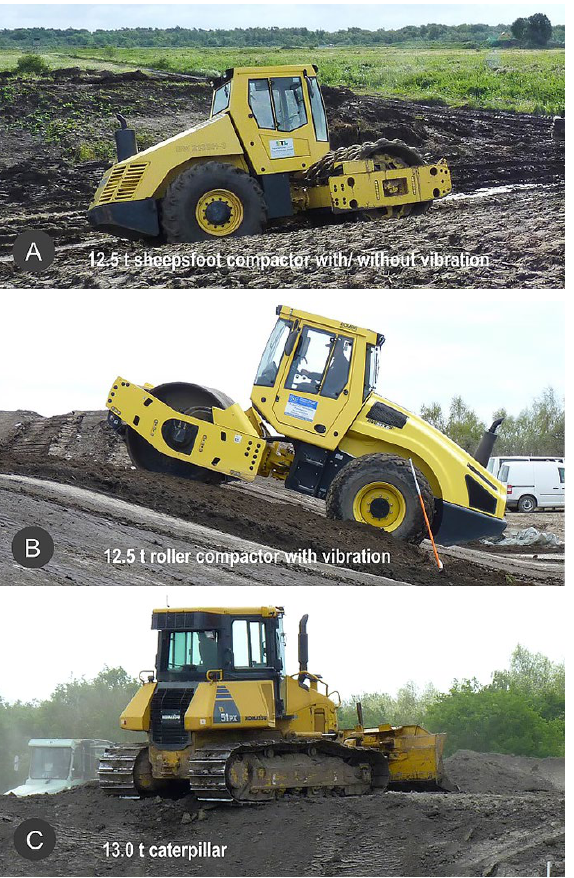
Fig. 8. Compactors used for the technology comparison Table 3. Results of the DOC analysis from the test dike Roller Caterpillar